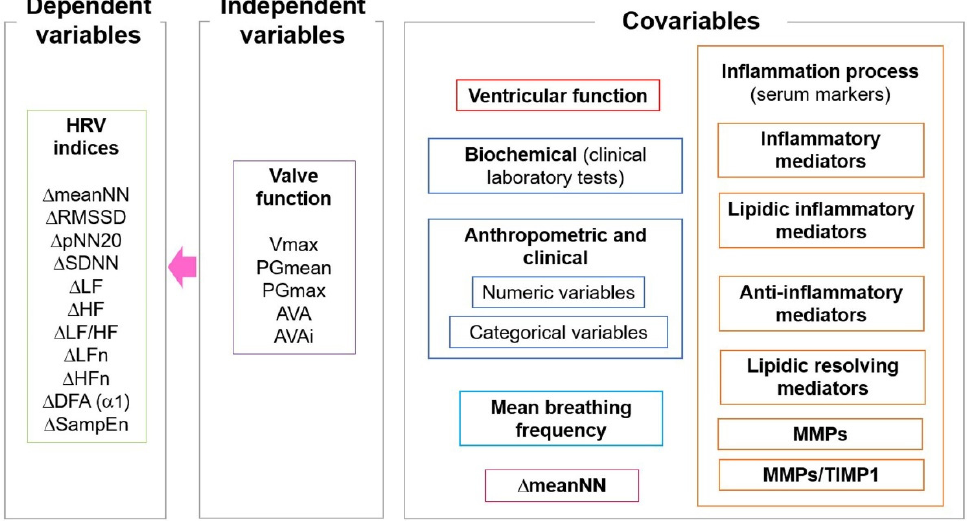
Figure 2. Conceptual framework of the studied variables. Vmax: maximum aortic valve transvalvular velocity; PGmean: mean pressure gradient, PGmax: maximum pressure gradient; AVA: aortic valve area, AVAi: aortic valve area indexed to body surface area; ∆ : the difference between values of heart rate variability (HRV) indices at the supine position minus values at active standing; meanNN: mean value of all NN intervals (RR intervals from sinus rhythm); SDNN: standard deviation of all NN intervals; RMSSD: root mean squared of the successive differences; pNN20: percentage of successive NN intervals with differences greater than 20 ms; LF: low-frequency band spectral power; HF: high-frequency band spectral power, n.u.: normalized units; LF/HF: ratio between low-frequency and high frequency spectral powers; 𝛼 1 : short-term scaling exponent, SampEn: sample entropy; MMPs: matrix metalloproteinases; TIMP1: tissue inhibitor of metalloproteinase-1.